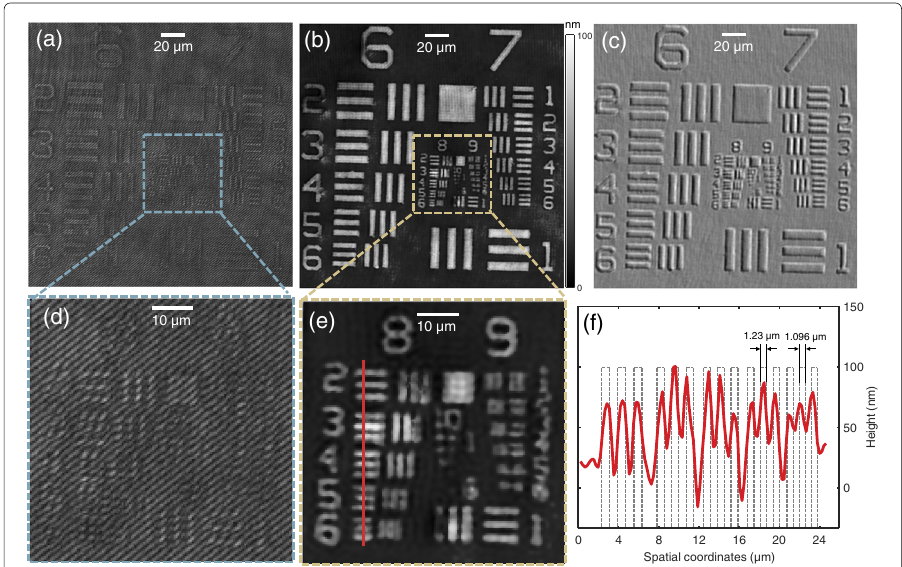
Fig. 9 Experiment for imaging resolution verification by standard phase resolution targets [Quantitative Phase Microscopy Target ( QPT TM ), Benchmark Technologies Corporation, USA]. (a) The captured hologram. (b) Reconstructed quantitative phase. (c) The phase gradient image generated from reconstructed quantitative phase by digital DIC method. (d) The enlarged sub-region of interest of the reconstructed quantitative phase in (a). (e) The enlarged sub-region of interest of the reconstructed quantitative phase in (b). (f) The quantitative profile of quantitative phase along the red line in